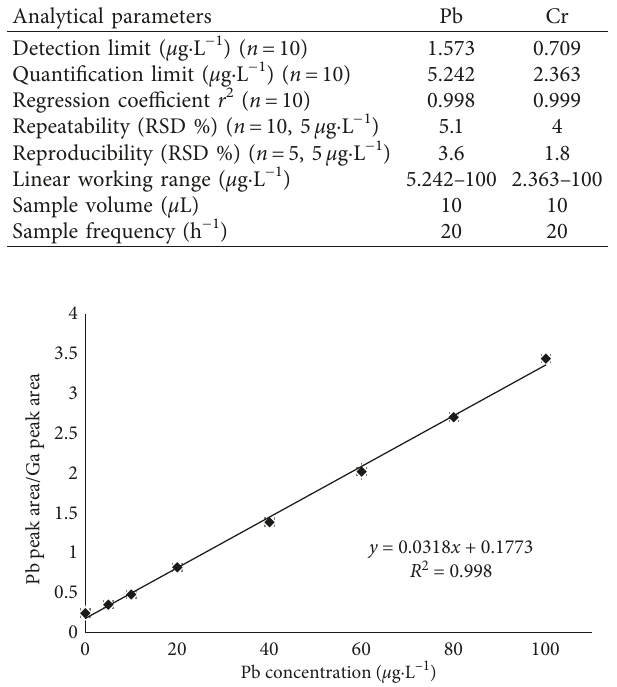
Figure 2: Calibration graph for Pb. Conditions: 0.005mol · L − 1 EDTA and 1mol · L − 1 HNO 3 . The error bars represent the standard deviation ( n � 3) for each point.